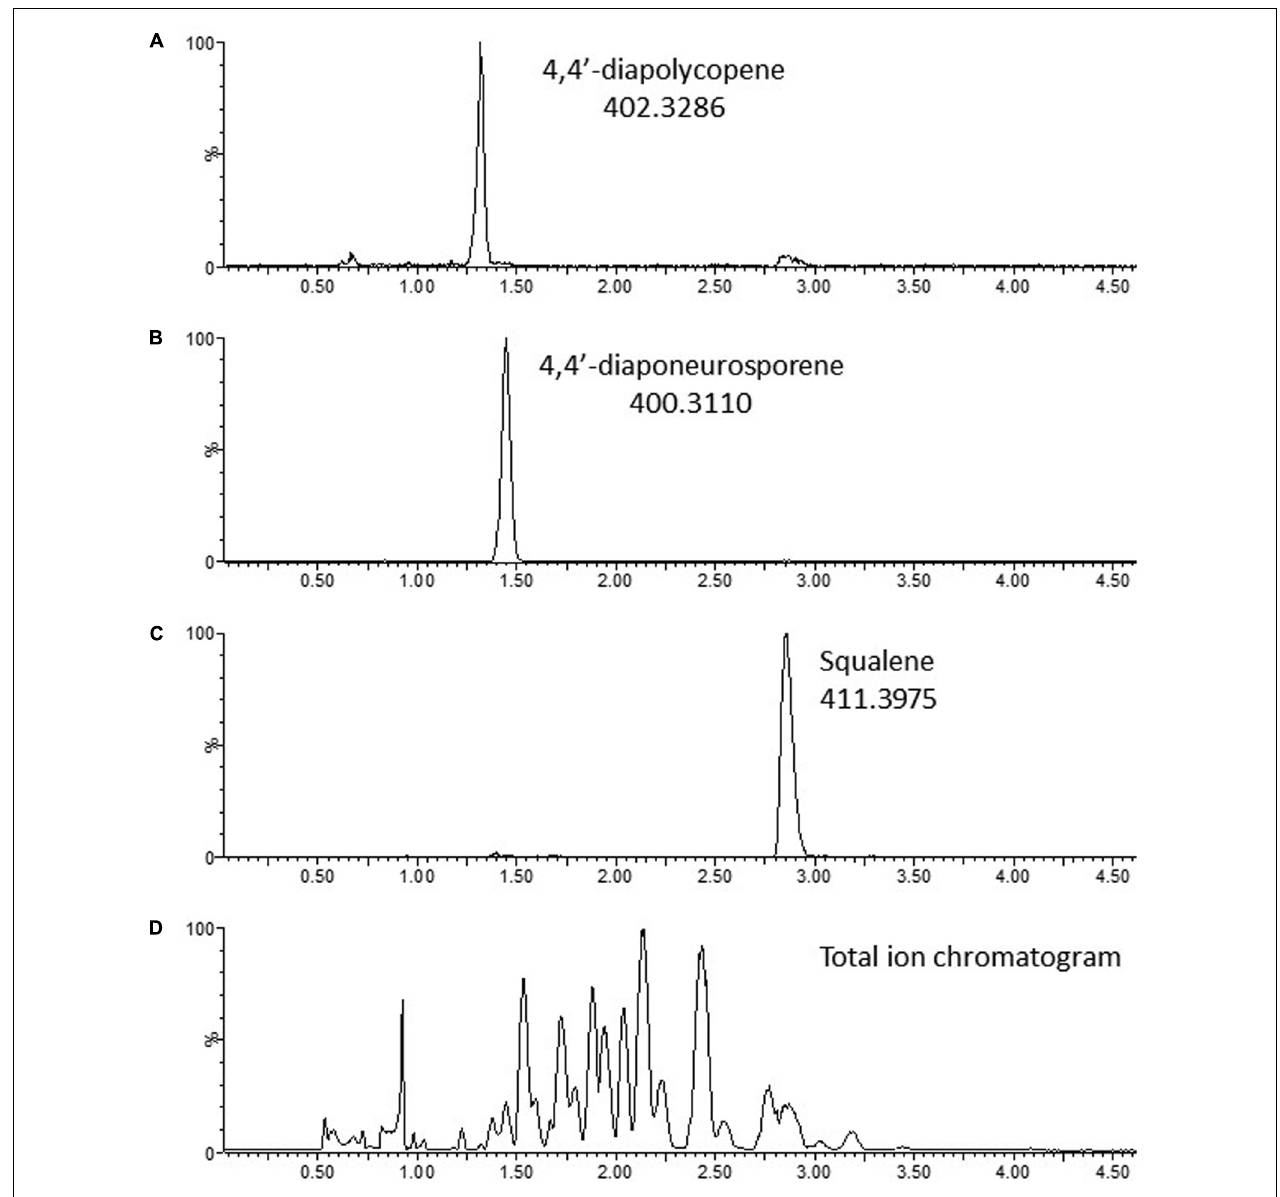
FIGURE 6 | Chromatograms of terpenoids produced by B. methanolicus MGA3 (pTH1mp-crtMN). (A) 4,4 (cid:48) -Diapolycopene; (B) 4,4 (cid:48) -Diaponeurosporene; (C) Squalene; (D) Total ion chromatogram. Continuum